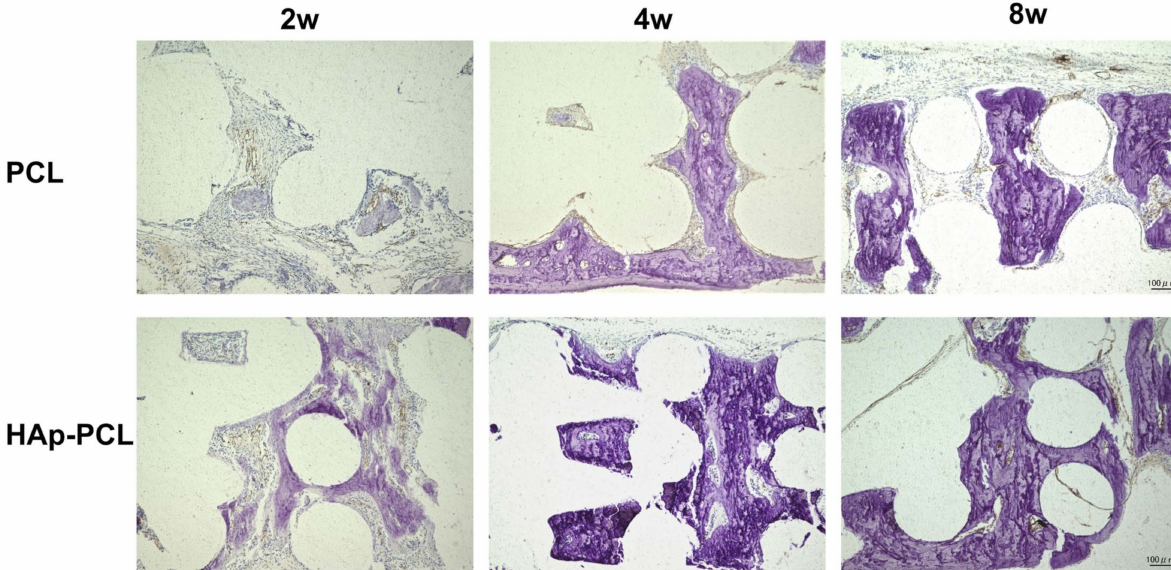
Figure 10. Immunohistochemical staining of von Willebrand factor (brown) for the sectioned tissue inside the scaffold at 2, 4, and 8 weeks after implantation of PCL or HAp-PCL into the critical-sized bone defect in rats. The tissues were counterstained with hematoxylin (purple). Scale bar was 100 µ